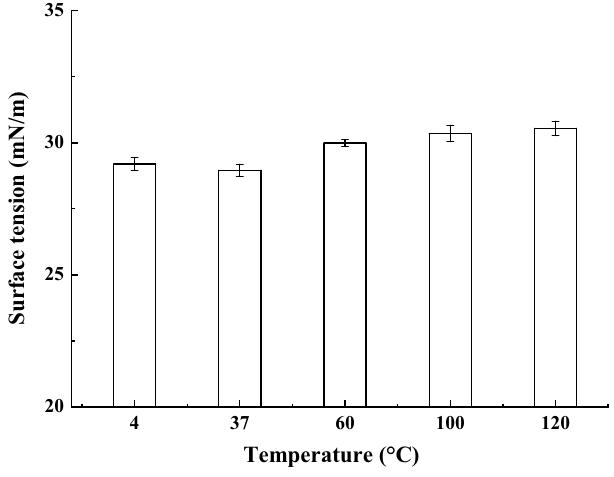
Figure 6. Effect of temperature on biosurfactatnt stability produced by B. subtilis SL.